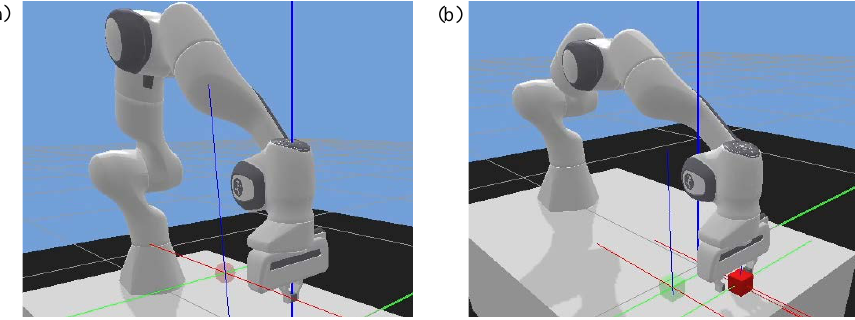
Figure 8. Two task scenarios. ( a ) Reaching task. ( b ) P&P